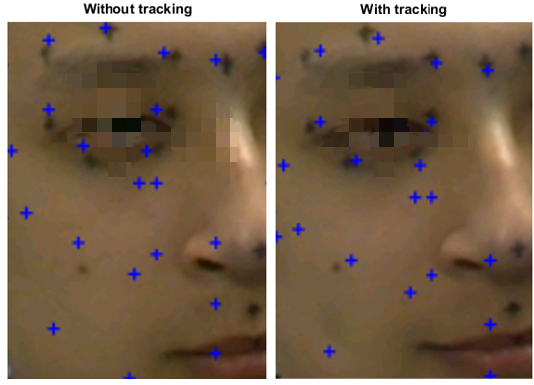
Figure 3: The comparison between non-tracking and tracking.